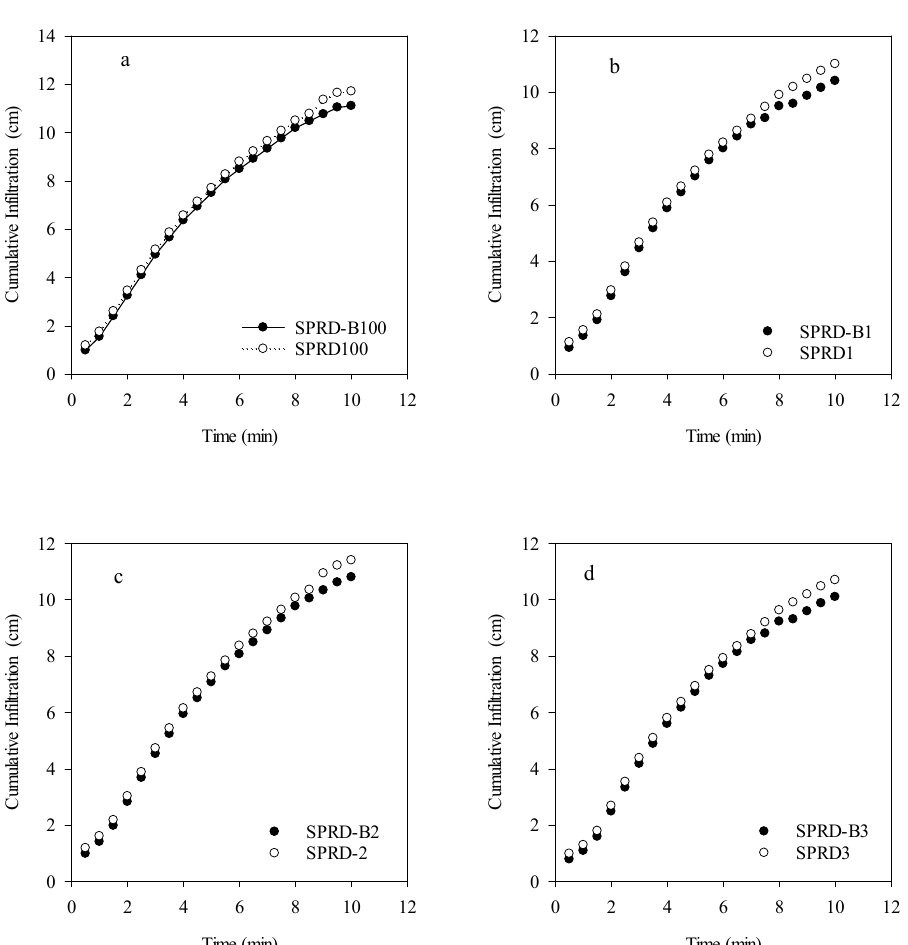
Figure 6. Cumulative infiltration of saline water under deficit irrigation with and without biochar, where ( a ) 100%, ( b ) 80%, ( c ) 60%, and ( d ) 40% of ETc.